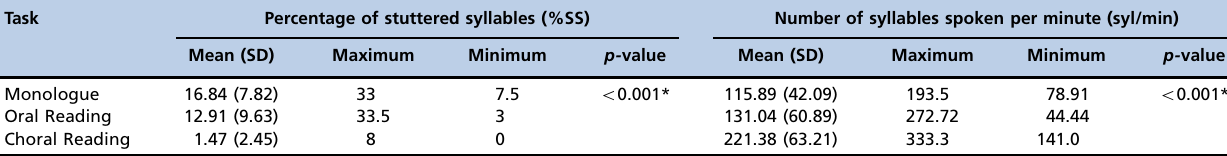
Table 1 - Description of speech fluency characteristics in each task for Group 1.